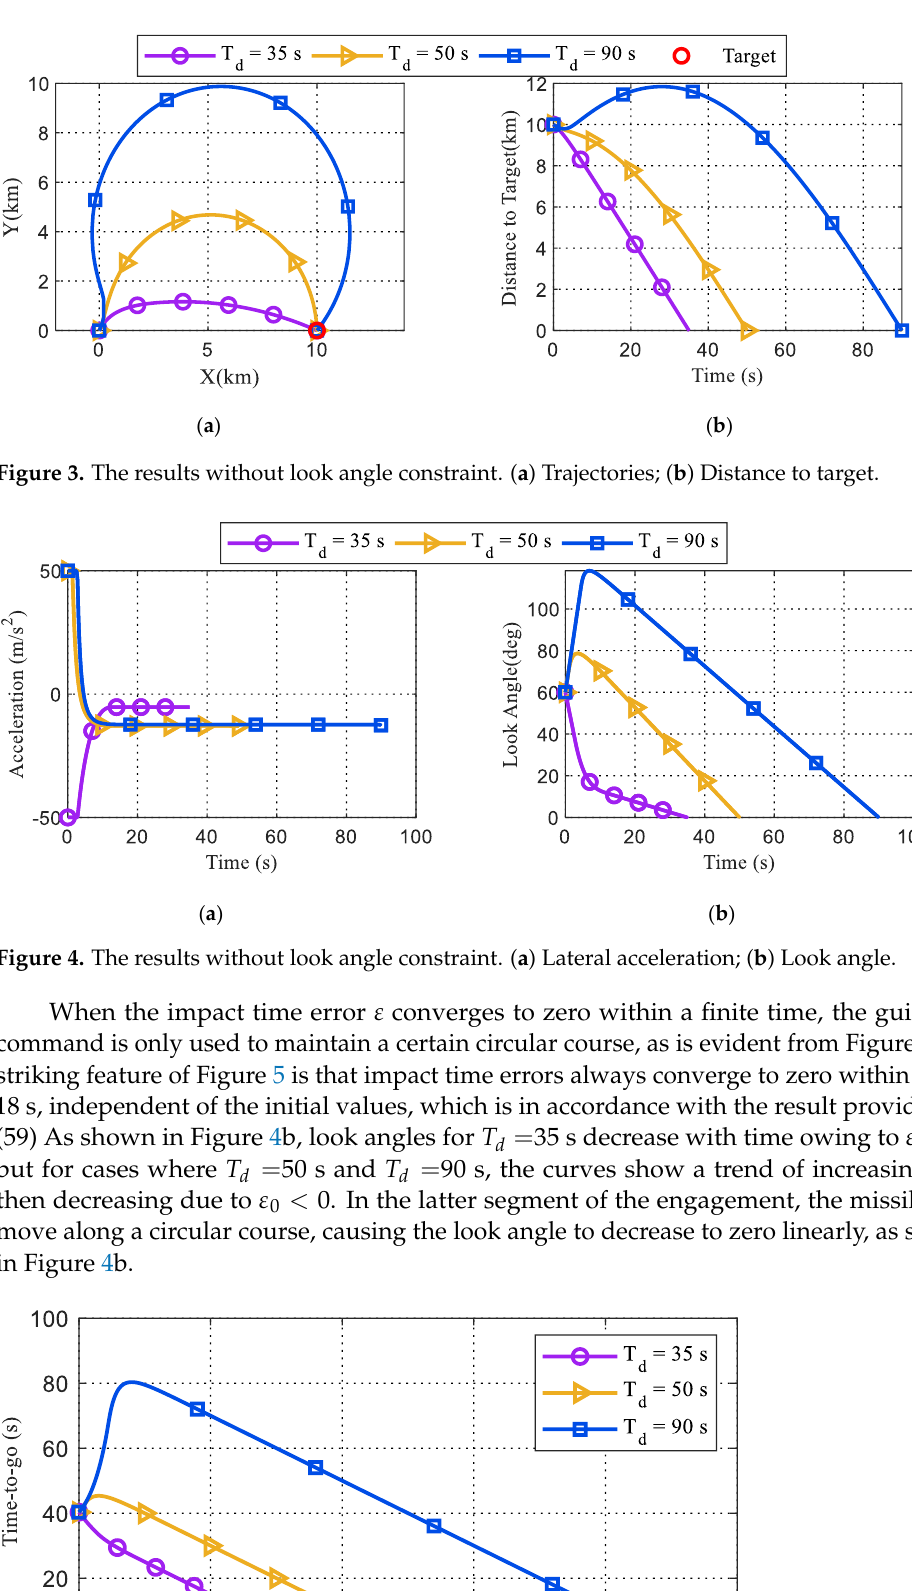
( b ) Figure 6. The results for different values of K under d T 50 s. ( a ) Trajectories; ( b ) Lateral acceler- ations.